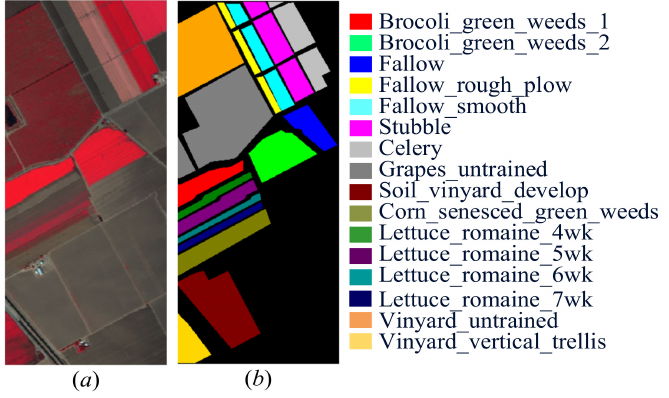
Figure 3. SA dataset: ( a ) false-color composite image; ( b ) ground-truth